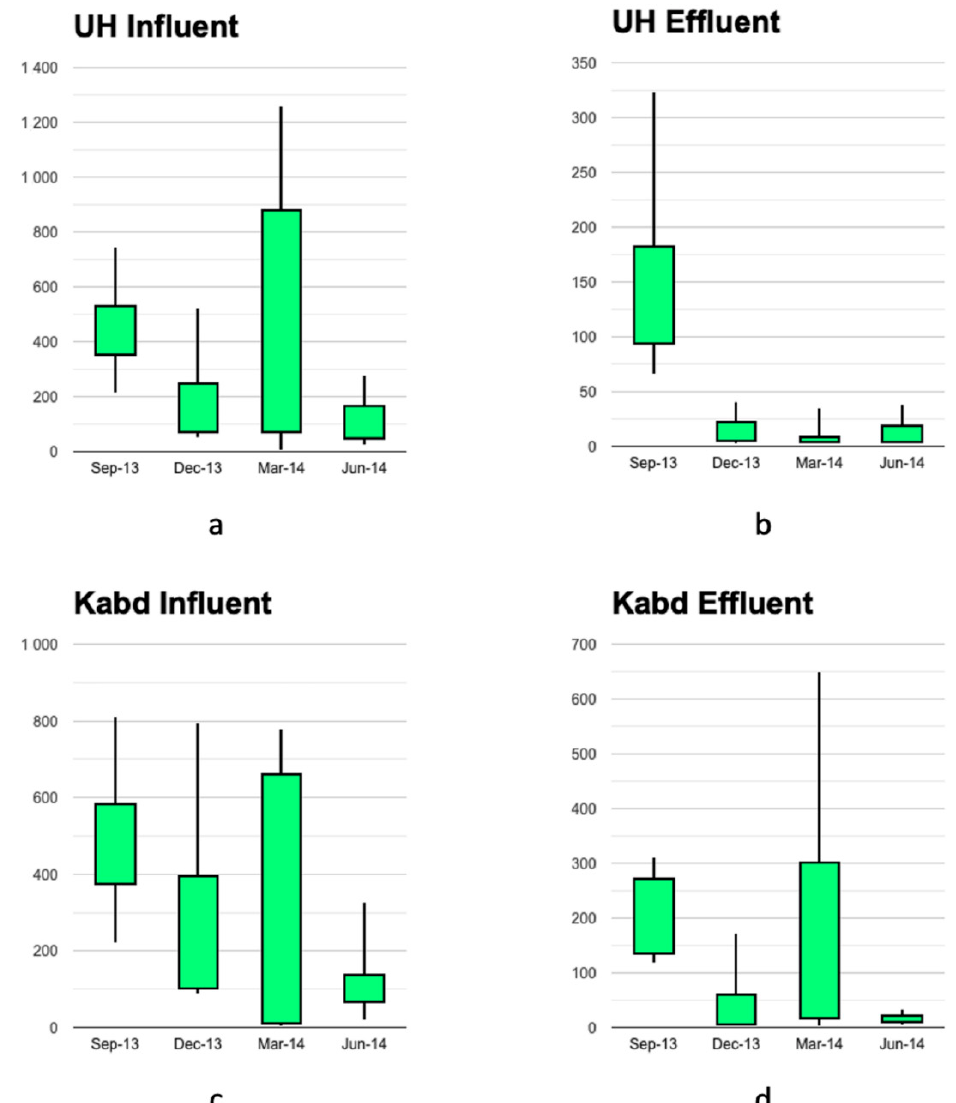
Figure 1. The concentration ( µ g/L) of various classes of antibiotics in the aqueous dissolved phase in the influents and effluents in two WWTPs in Kuwait.